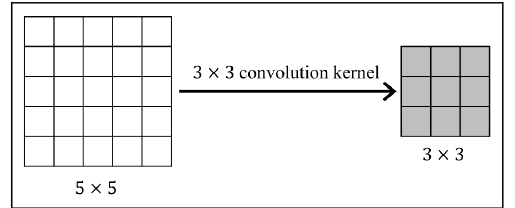
Figure 1. Illustration of Convolution.